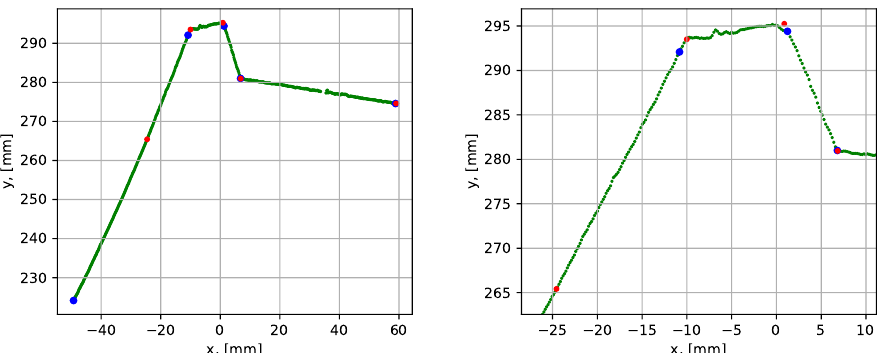
Figure 18. Parametrization results with groove corner points for dataset 2. The blue dots show the result before the iterative error elimination procedure and the red dots show after. A close-up of the graph is shown to the